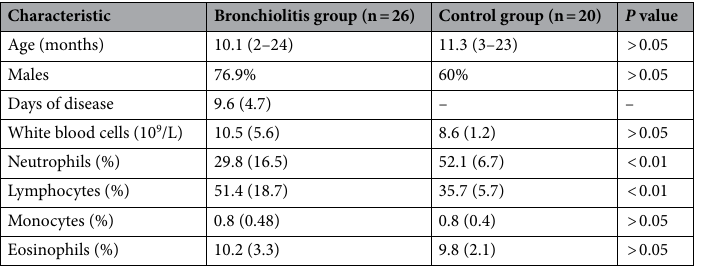
Table 1. Demographic and clinical characteristics of the study subjects. Data are expressed as median (range) or percentage